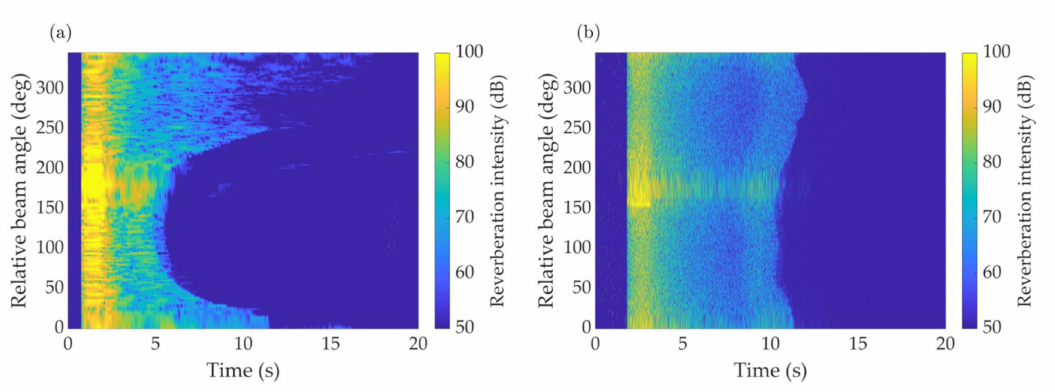
Figure 11. Modeled beam time series. ( a ) Ping 107 (CW reverberation) and ( b ) ping 324 (LFM reverberation).